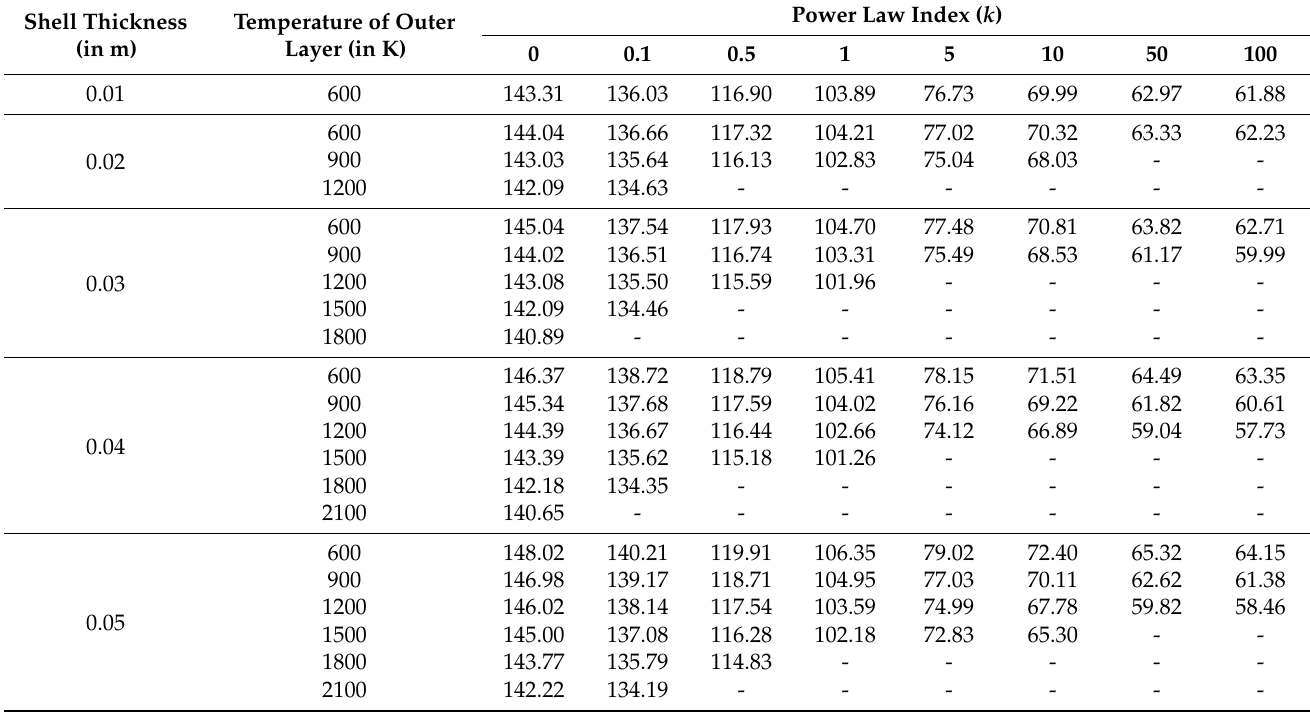
Table 14. Natural frequency (in Hz) of a Ti-6Al-4V/silicon carbide FGM shell under a linear tempera- ture rise for various shell thicknesses in re-entry vehicle nose